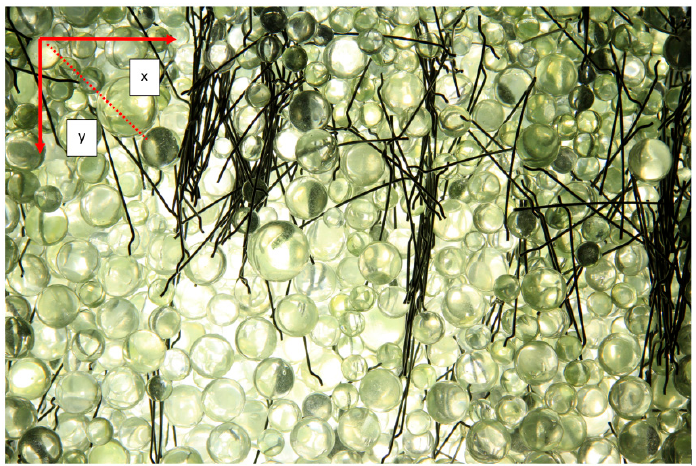
Figure 10. Strips and 2nd